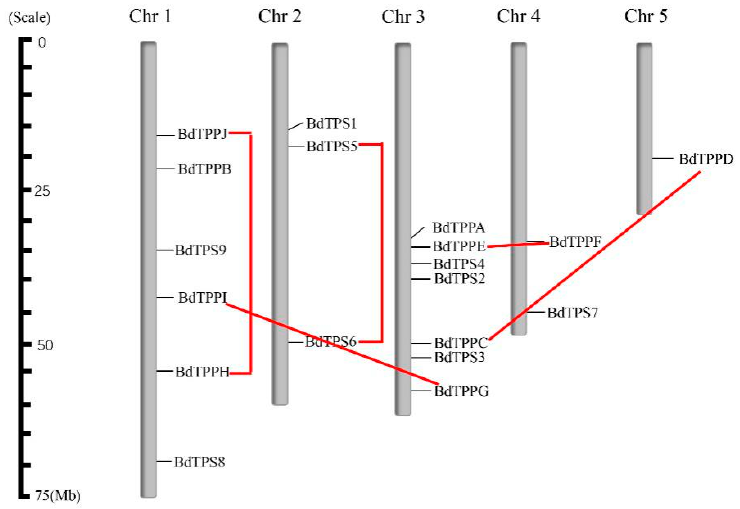
Figure 3. Chromosomal location and gene duplication of BdTPSs / BdTPPs. The chromosome numbers are indicated above, and red lines represent the duplication gene pairs. Table 2. The duplicated BdTPS / BdTPP genes and Ka / Ks